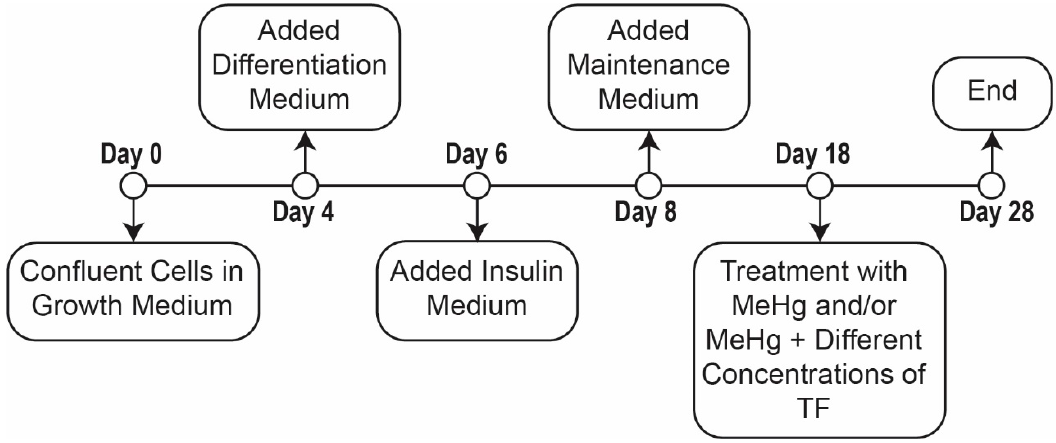
Figure 5. Timeline of the exposure study.